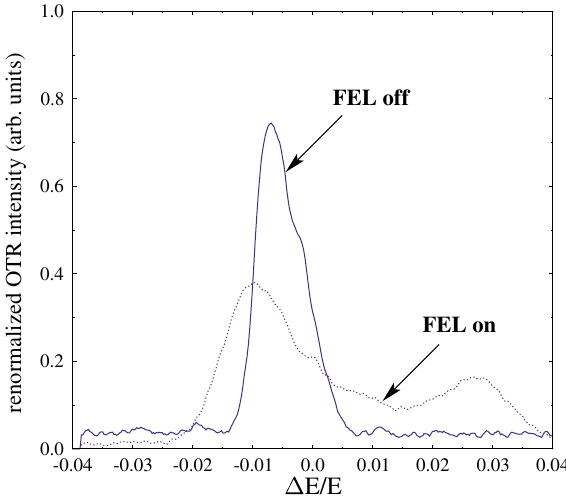
FIG. 7. (Color) Impact of the FEL process on the beam frac- tional momentum profile. The energy profiles are measured in the ‘‘decompressor’’symmetry point using an optical transition radiation profile monitor.